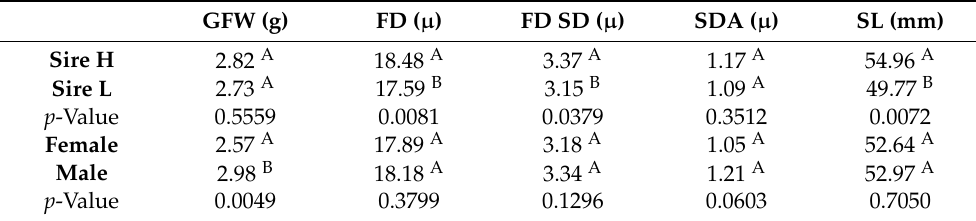
Table 1. Wool measurements by sire and by sex of lambs artificially infected with H. contortus . Data include grease fleece weight (GFW), fiber diameter (FD), fiber diameter standard deviation (FDSD), standard deviation along the wool fiber (SDA), and staple length (SL).